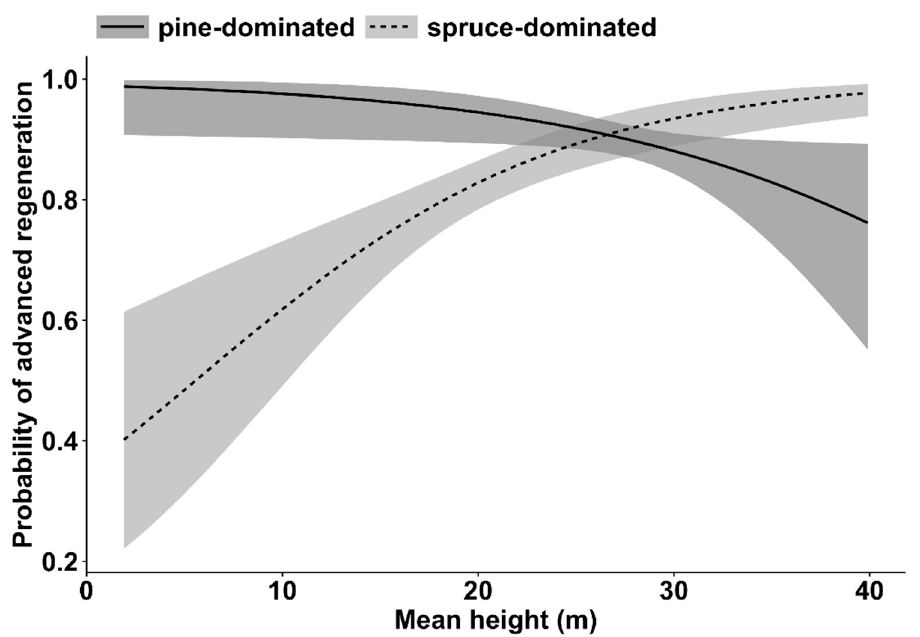
Figure 4. The influence of mean height (m) on the occurrence probability of advance regeneration in Scots pine and Norway spruce-dominated stands. The grey area represents the ±95% confidence interval. Table 1. Parameter estimates of the best (by AIC) fitted binomial generalized linear model (GLM) models for advance regeneration. (Df): degree of freedom, *: interaction between factors.